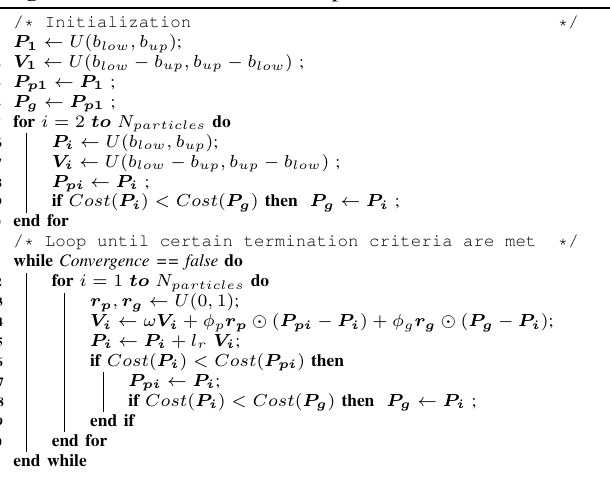
Algorithm 1: Particle Swarm